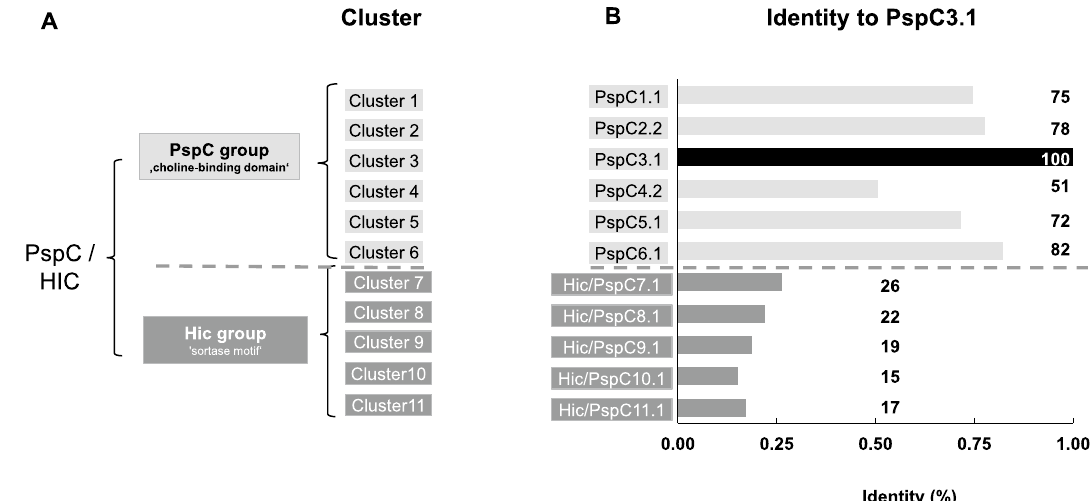
Figure 1. Diversity of PspC and Hic cluster variants. PspC and Hic proteins were initially considered to represent one protein class that, based on the different surface anchors, can be divided into two major groups. ( A ) PspC variants with choline-binding domains representing the PspC group, and Hic variants with sortase dependent LPsTG motifs for cell wall anchoring representing the Hic group. For each group additional clusters were identified. For the analysis one variant from each cluster was selected, i.e. for the PspC group: PspC1.1, PspC2.2, PspC3.1, PspC4.2, PspC5.1, PspC6.1; and for the Hic group: Hic/PspC7.1, Hic/PspC8.1, Hic/PspC9.1, Hic/PspC10.1, Hic/PspC11.1. ( B ) Amino acid identity of the full-length selected cluster variants with PspC3.1. The variation identified for the six PspC and the five Hic variants selected is indicative of compositional variation among the two major protein